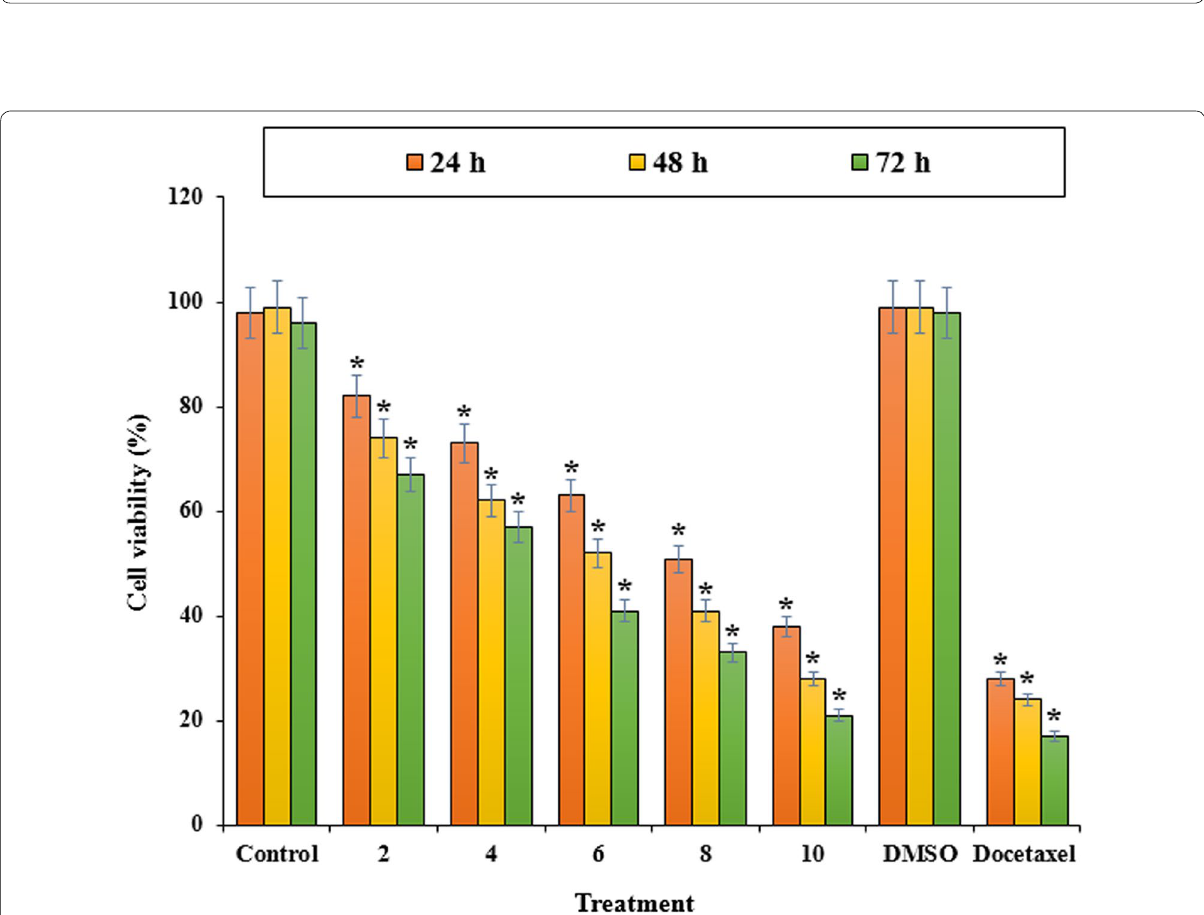
Fig. 3 The effect of L. usitatissimum extract on the viability of LNCaP cells. The viability percentage was measured by MTT assay. LNCaP cells were treated with different concentrations of the extract for 24, 48, and 72 h. *Indicate the significant difference ( p < 0.01) between experimental groups with control/DMSO